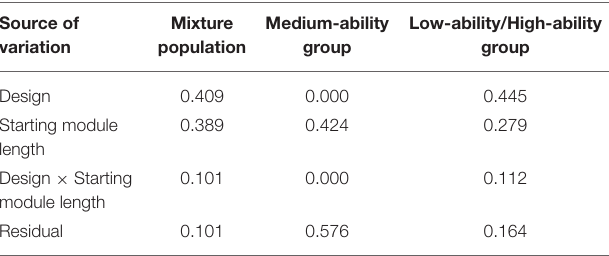
TABLE 7 | Effect sizes ( η 2 ) for main effects and interactions of the factors design (MST vs. TMST) and starting module length on RMSE( ˆ θ